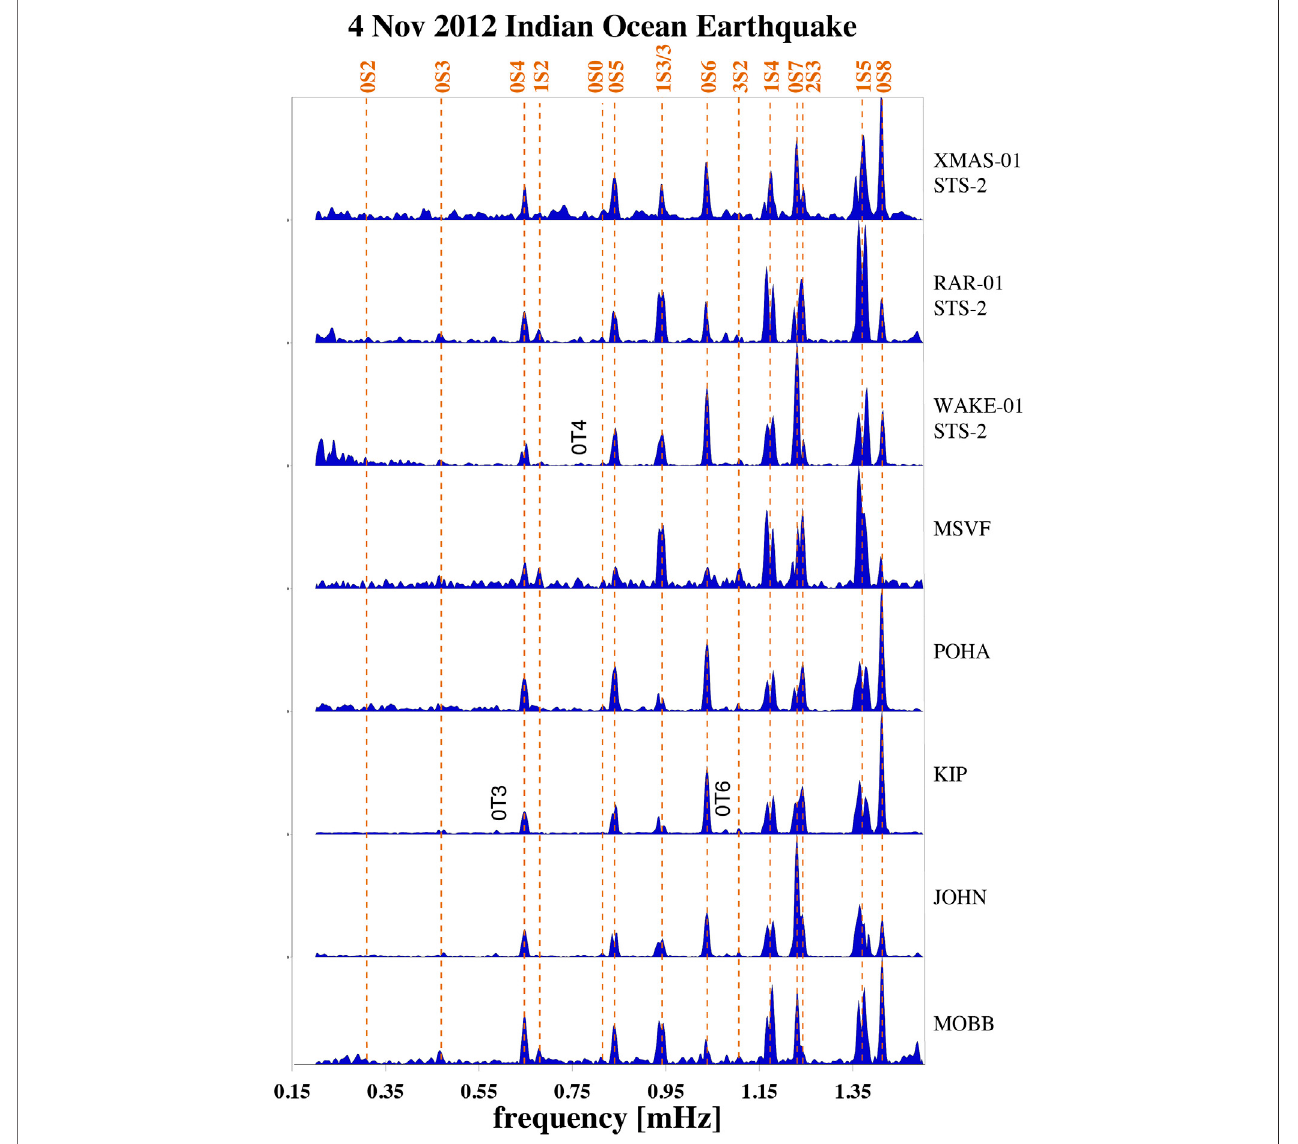
FIGURE 12 | Normalized raw vertical-component spectra at GSN stations for the April 11, 2012 Indian Ocean earthquake of 60-hour long segments, starting 2 h after the event time. A code 01 after the station code means that we use the secondary sensor for analysis (sensor type below the station name). Also shown is the spectrum of sea fl oor observatory MOBB off-shore California (see Figure 13